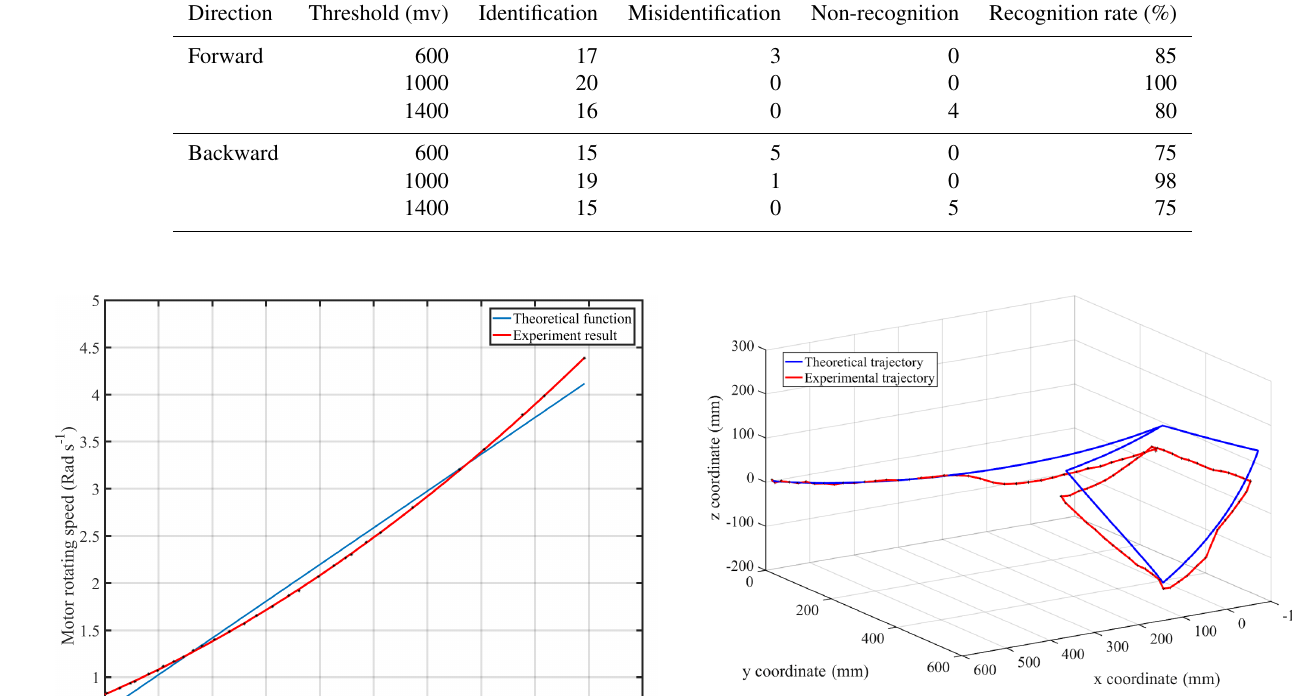
Figure 9. End-effector trajectory in the active training control ex-